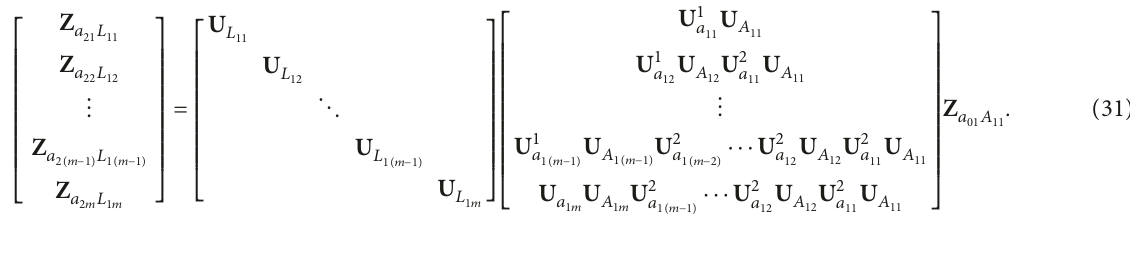
L ni and (b) beam ( n − 1 ) i .